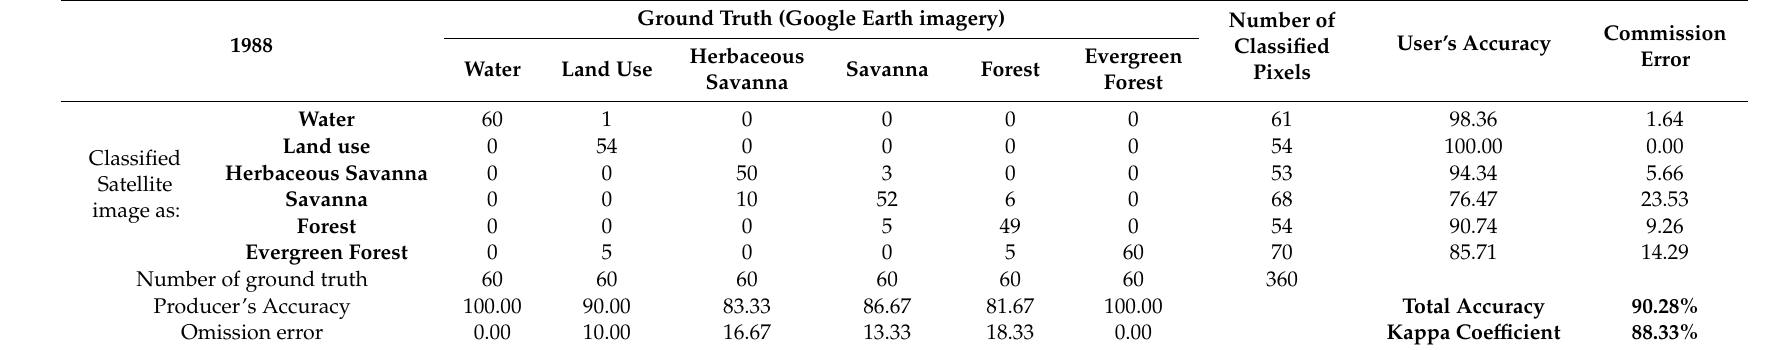
Table A1. Confusion matrix of the land use / cover classification for 1988.